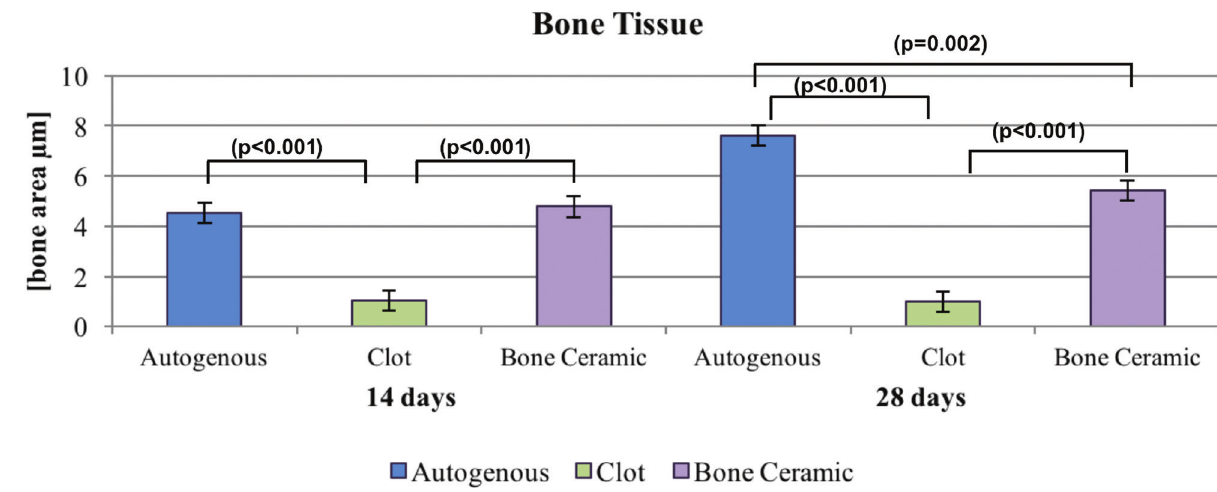
Figure 2- Neoformed bone tissue at 14 and 28 days